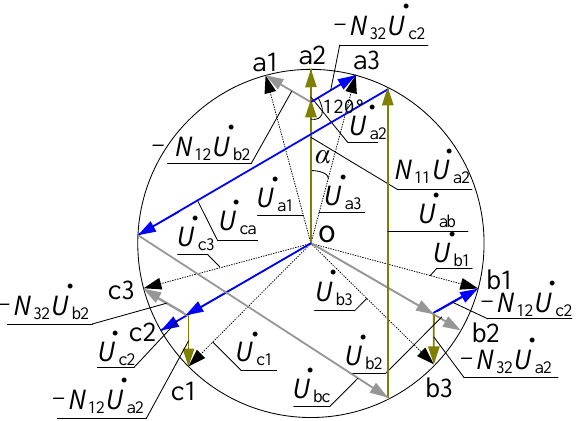
Figure 2. Vector diagram of the isolation transformer. a1, a2, a3, b1, b2, b3, c1, c2, c3 are the vectors of the output phases of the main transformer.